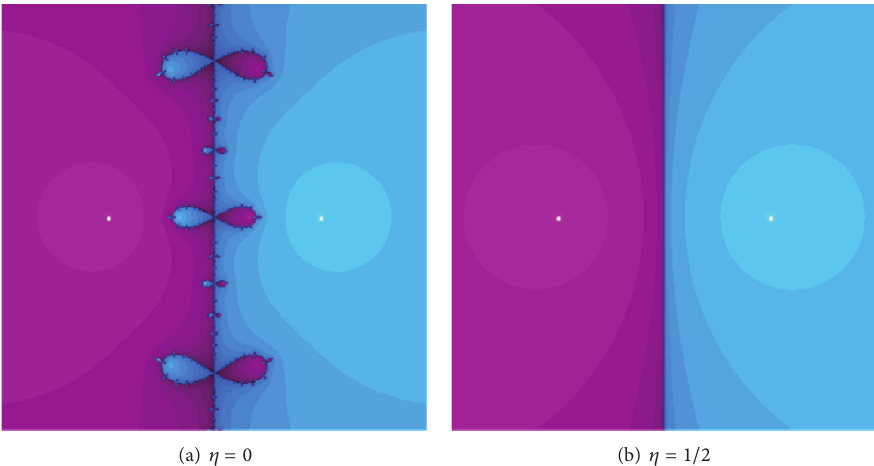
Figure 1: Basins of attraction for different methods of family (14) for 𝑓(𝑥) = 𝑥 2 − 1 shaded according to the number of iterations.